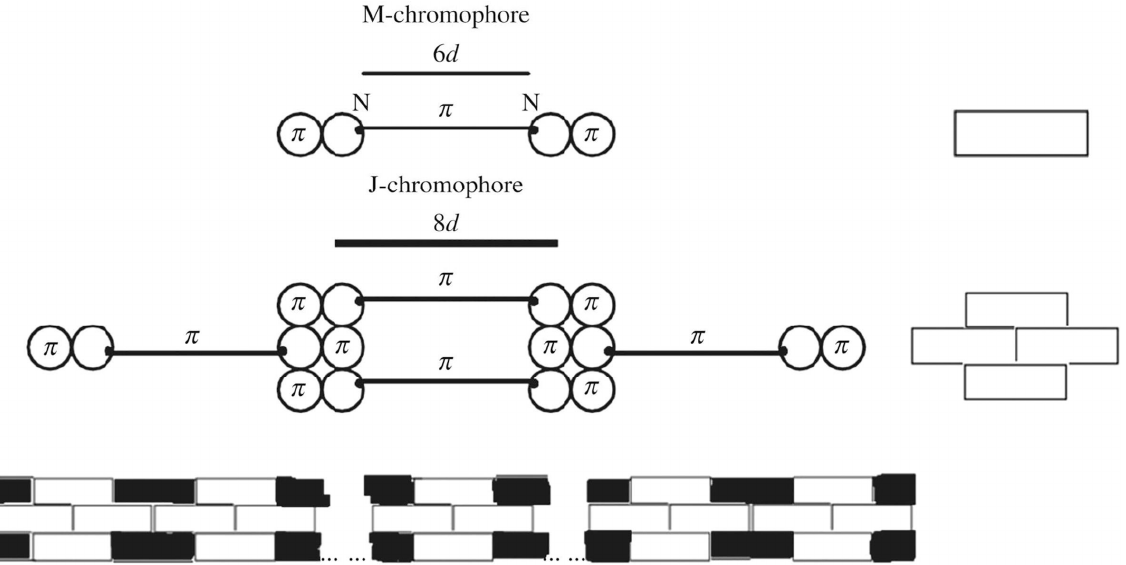
Figure 5. Scheme of polymethine dye chromophore elongation as a result of J-aggregation. The J-chromophore consists of four identical molecules forming a brickwork-like structure [7,36,74,75] in which the π -electron system of the polymethine chain joins with the π -electron system of the benzene rings of two neighboring monomers ( d is a some unit bond length). The fourth molecule is “neutral” with respect to the formation of a common π -electron system and acts as a stabilizer of the J-chromophore structure [6,7,22–26]. The J-aggregate is a thin and long “rod” composed of J-chromophores [6,7,22–26].